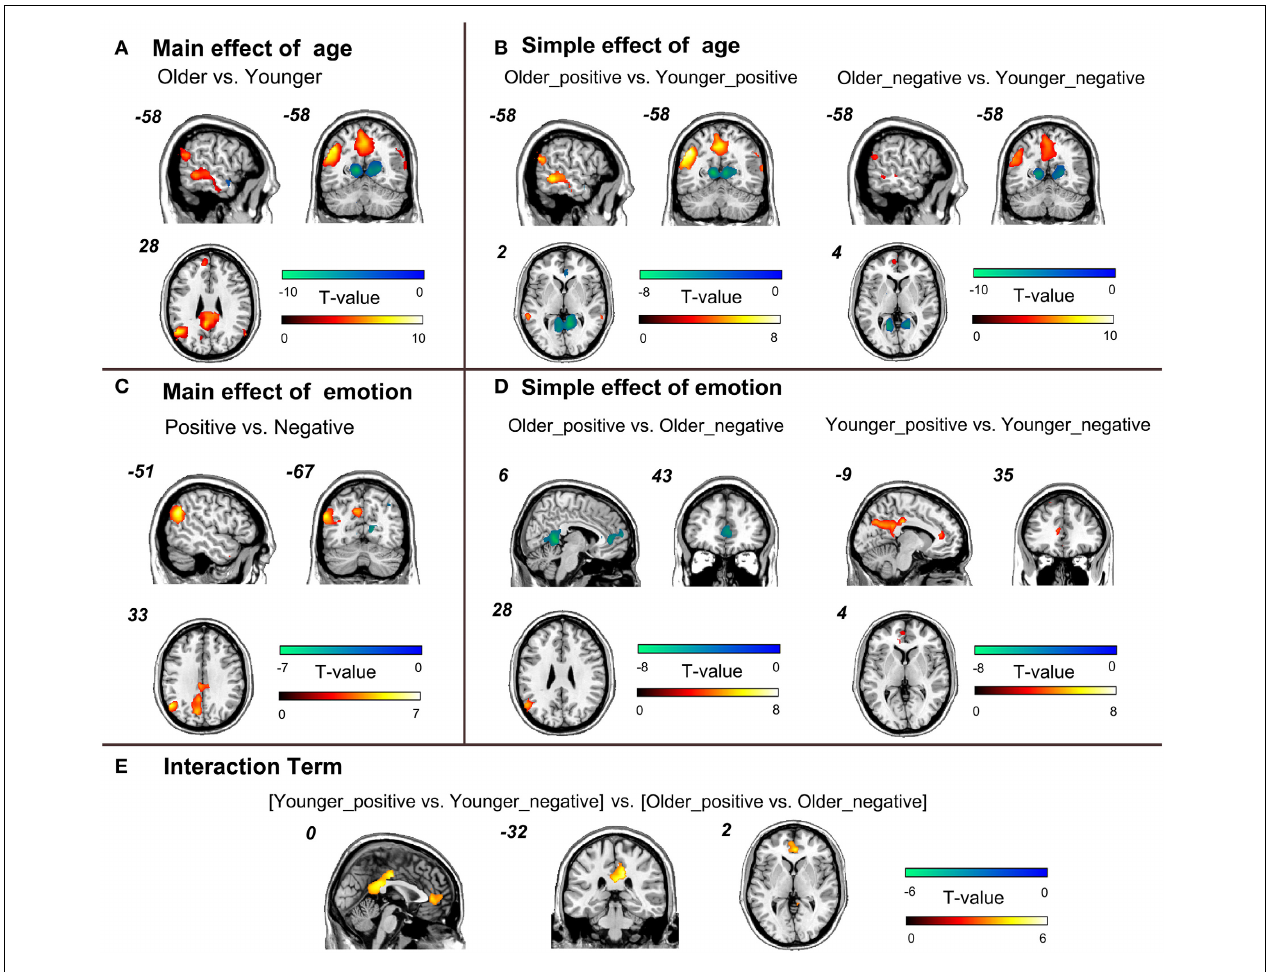
FIGURE 5 | Brain regions showing significant main, simple, and interaction effect of age and emotion. (A) Brain regions showing significantly main effect of age. (B) Brain regions showing significantly simple effect of age. (C) Brain regions showing significantly interaction between age